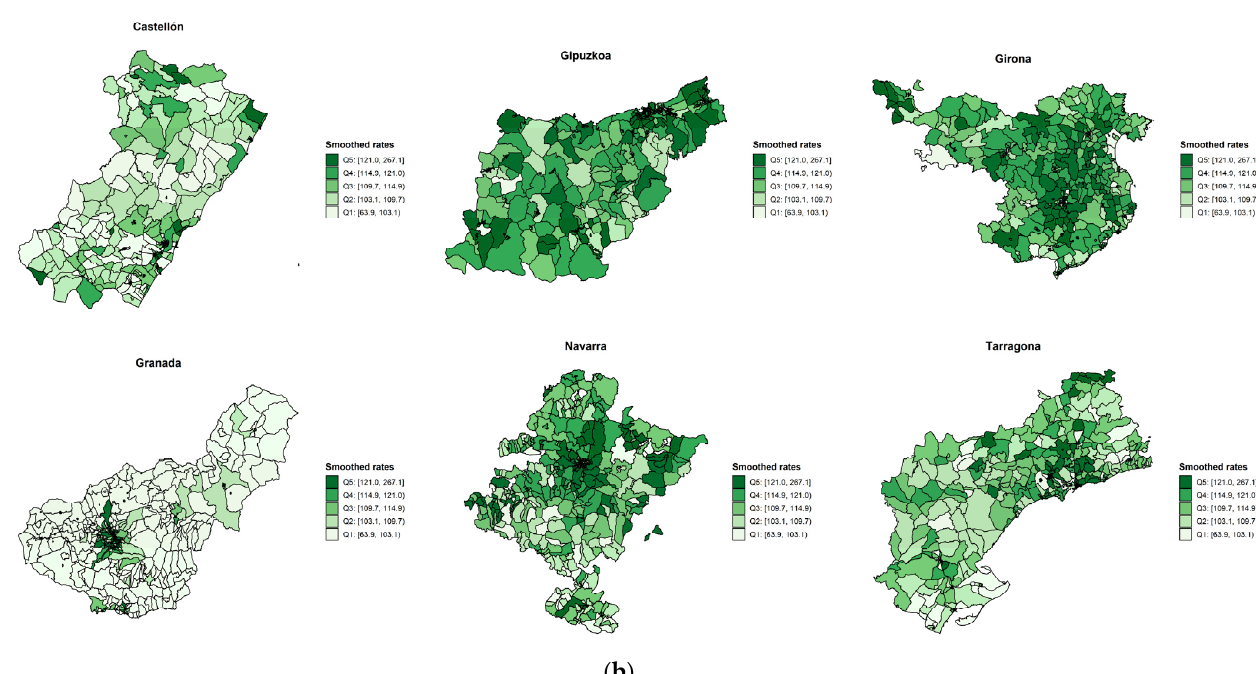
Figure 4. ( a ) Breast observed incidence rates and ( b ) smoothed cancer incidence rates adjusted for deprivation and age by census tract in seven Spanish provinces during the period 2010–2013.